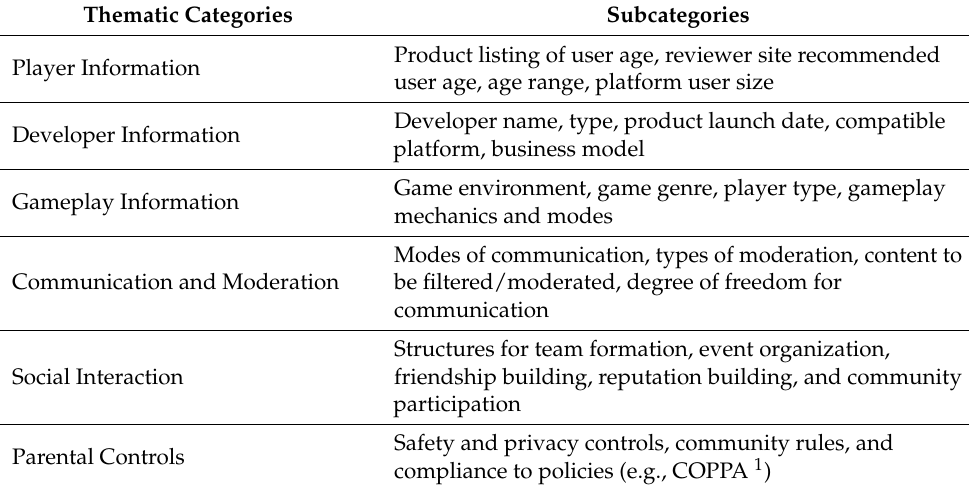
Table 1. Themes and subcategories for the 22